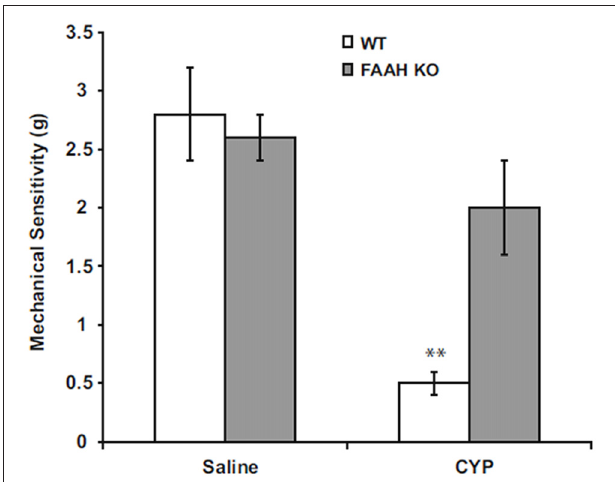
FIGURE 2 | Peripheral mechanical sensitivity determined by application of von Frey monofilaments to hind paws 24 h after treatment with intraperitoneal saline (controls) or CYP (150 mg/kg). Mean ± SEM. ∗∗ p < 0.01; vs. saline treated; n = 6–8. Reprinted by permission from the publisher of Journal of